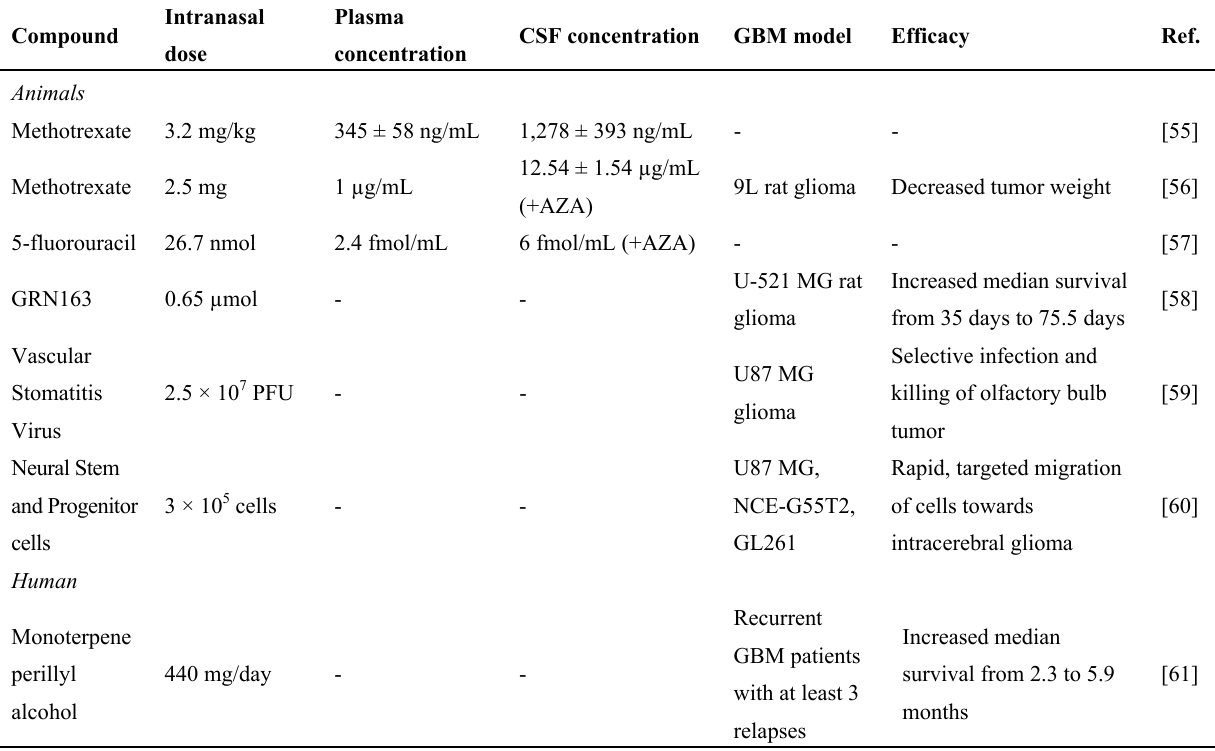
Table 1. Intranasal administration of pharmacological agents for the treatment of GBM,